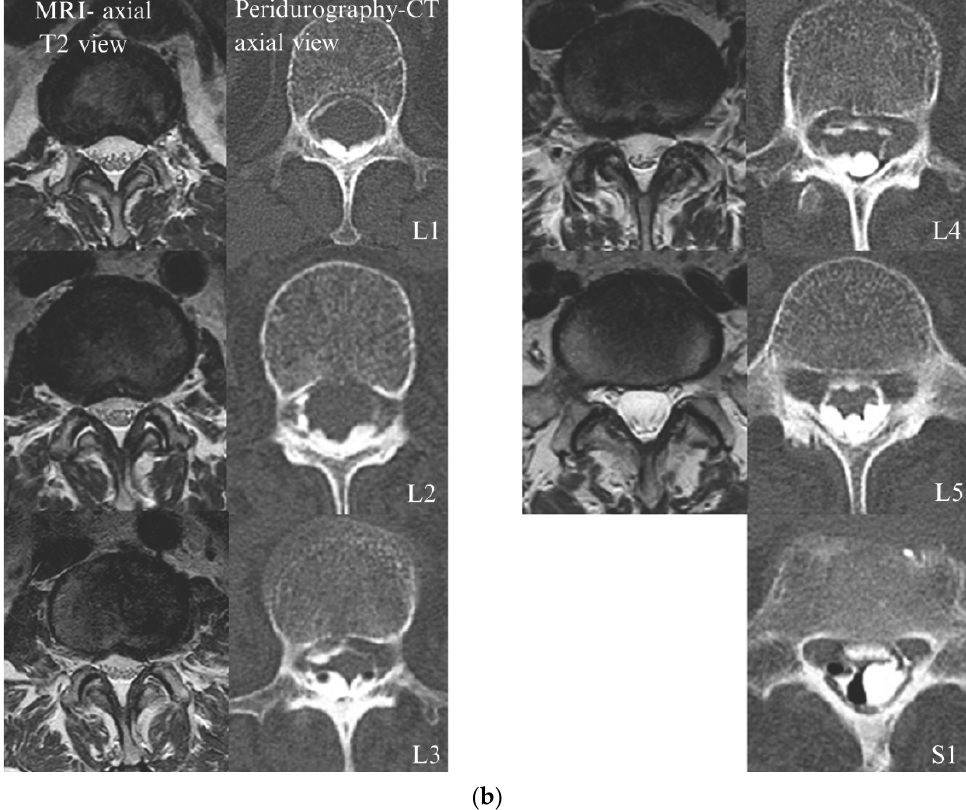
Figure 5. ( a ) MRI sagittal T2 view and CT epidurography sagittal view. CT, computed tomography; MRI, magnetic resonance imaging. ( b ) MRI axial T2 view and CT epidurography axial view. CT, computed tomography; MRI, magnetic resonance imaging.